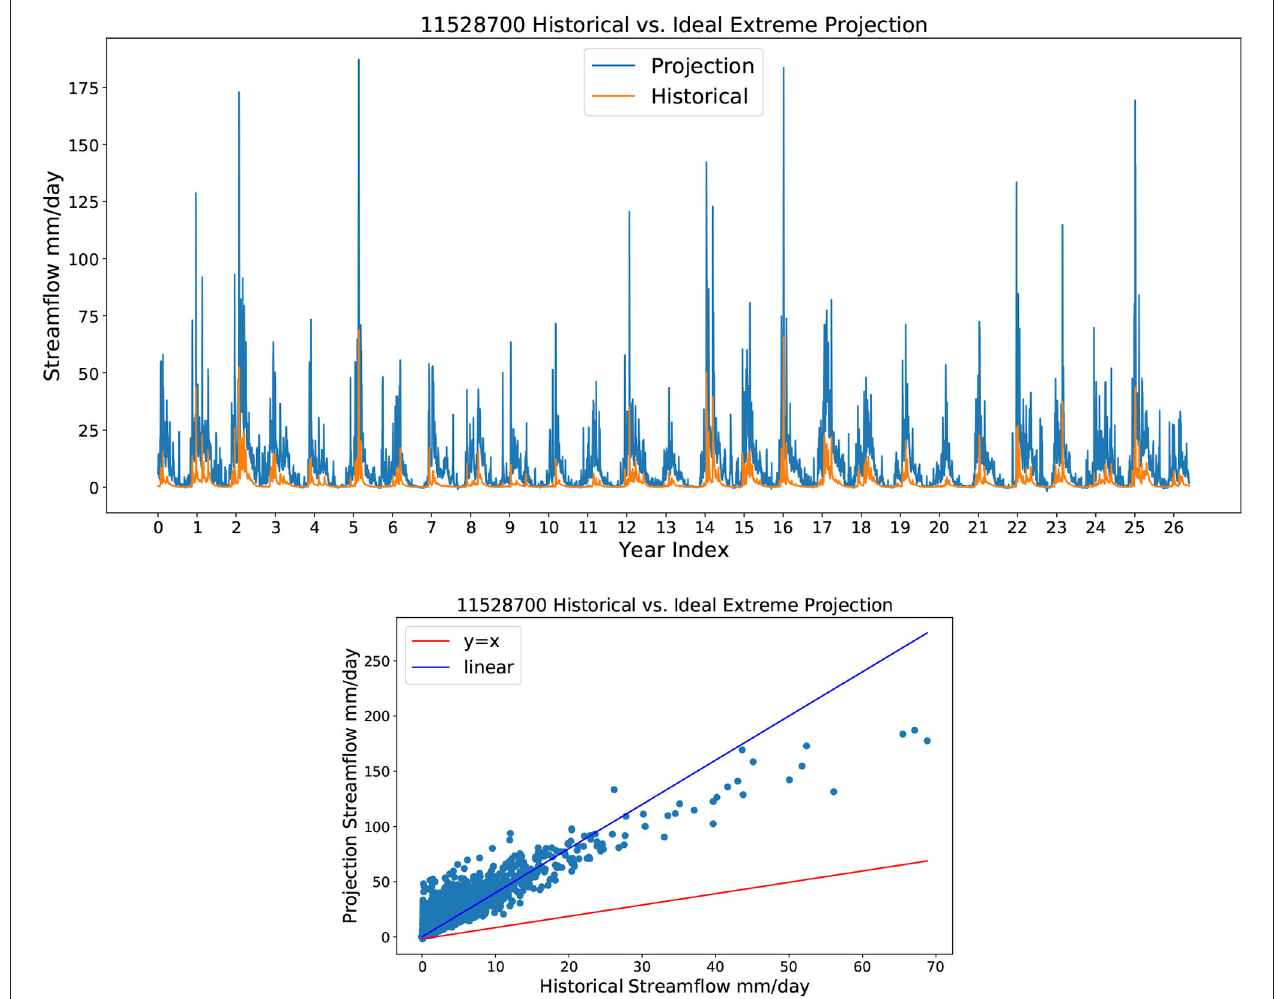
FIGURE 3 | A depiction of the streamflow response under idealized extreme forcing showing (top) time series of flow and (bottom) historical streamflow vs. projected